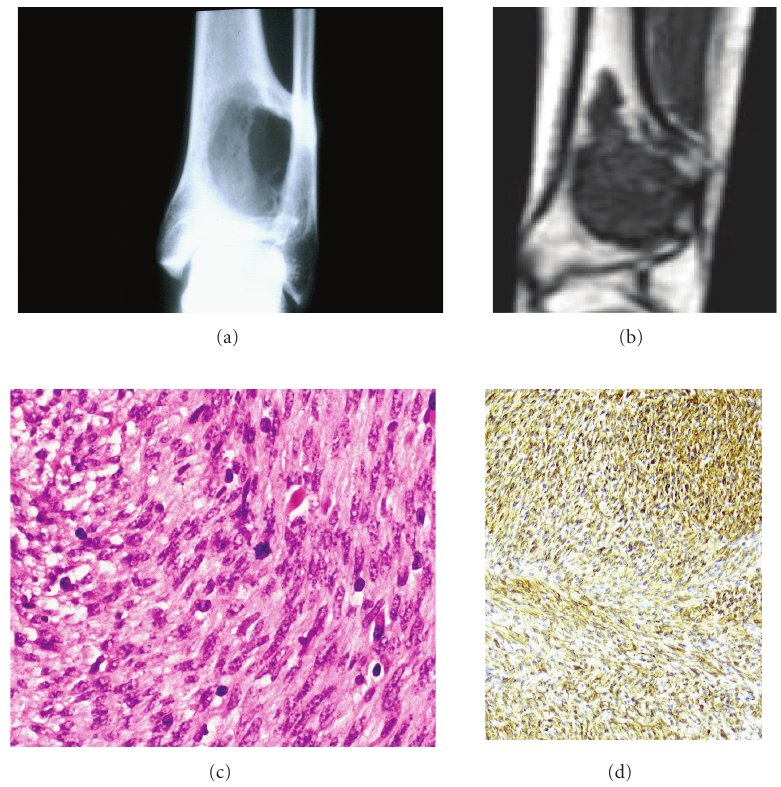
Figure 1: (a) Conventional radiograph reveals an osteolytic lesion in metadiaphysis of the left distal tibia with cortical destruction. (b) T1- Weightened Magnetic Resonance Image shows a well-defined low density intramedullary location with cortical breakthrough. (c) Interlacing bundles of spindle cells with enlarged shaped atypical nuclei and eosinophilic cytoplasm (H&E, x40). (d) Tumor cells are immunostained by the antibody against Actin